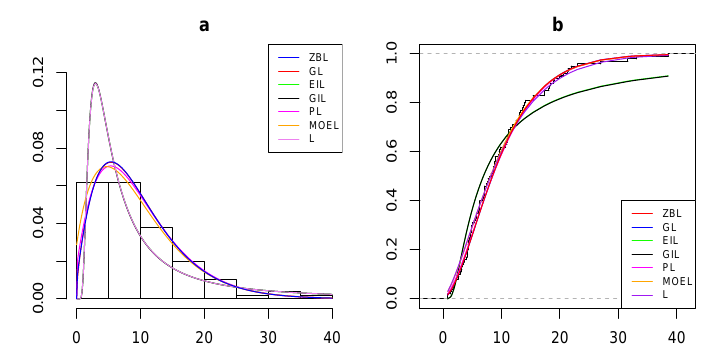
Figure 3 – Fitted densities (a) and cumulative densities (b) of data of waiting times of 100 customers.